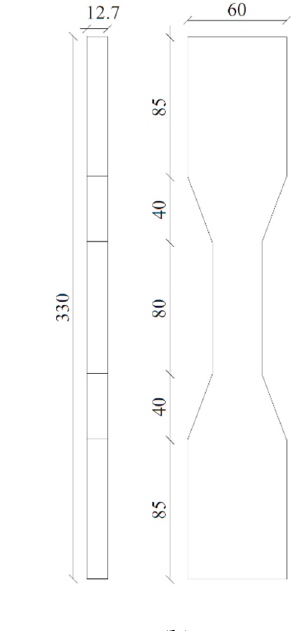
Figure 4. The direct uniaxial tensile test: ( a ) test setup with DIC and ( b ) specimen dimension (mm). 174